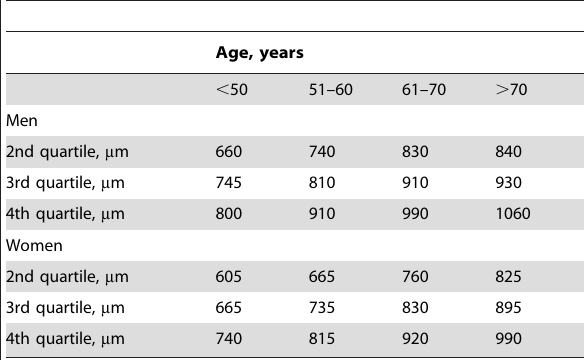
Table 4. The age-related borderlines for distribution of mean cIMT in Moscow